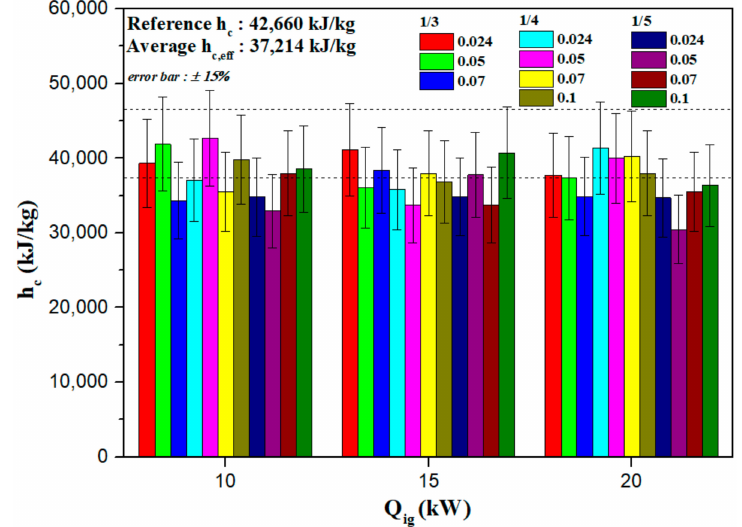
Figure 7. The results of the e ff ective heat of combustions with volume fraction 0.024, 0.05, 0.07, and 0.1 for scale factor 1 / 3, 1 / 4, and 1 / 5.